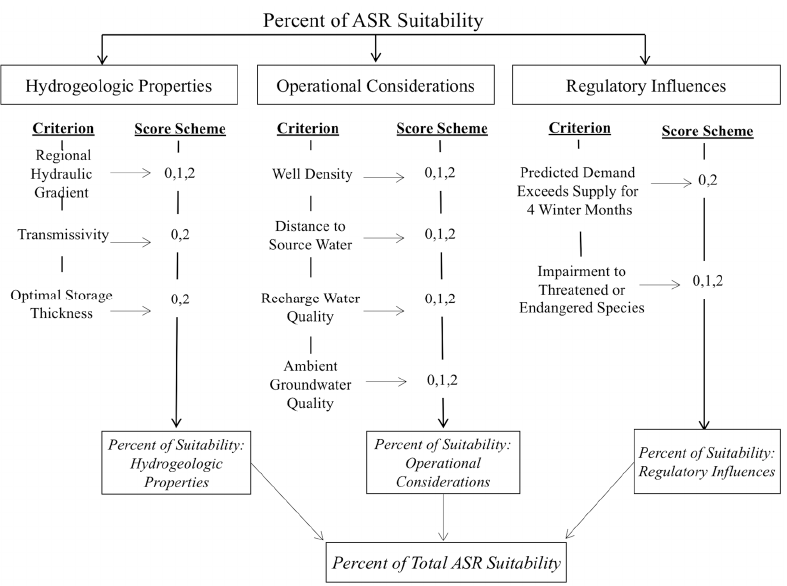
Figure 4. Scoring system to determine ASR suitability.